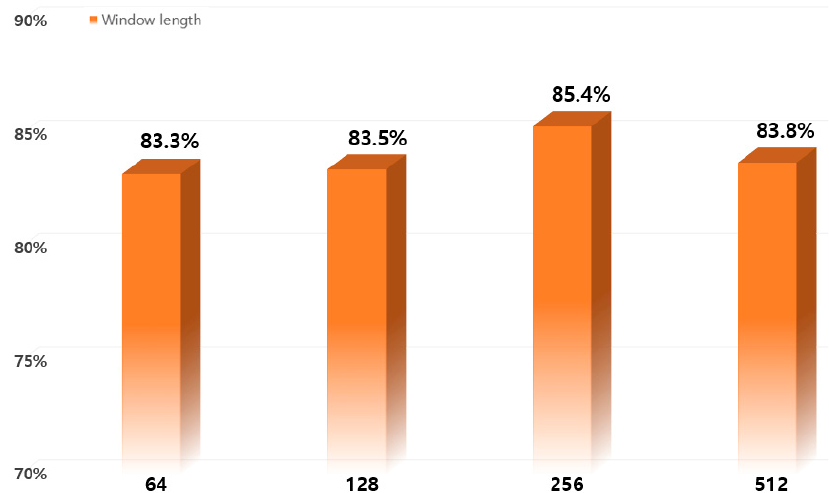
Figure 12. Identification performance based on changes in window length.